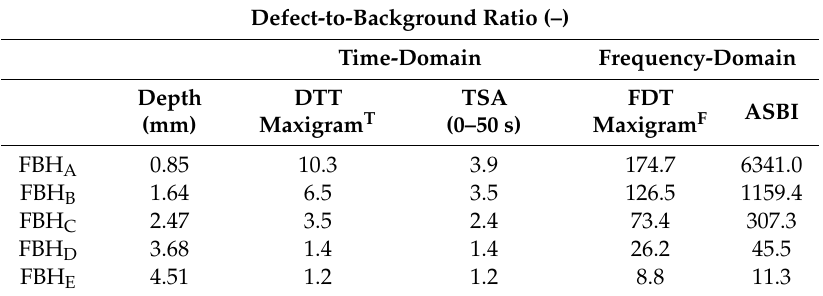
Table 2. Defect-to-background ratio (DBR) for all FBHs of the CFRP FBH coupon sample. Defect-to-Background Ratio